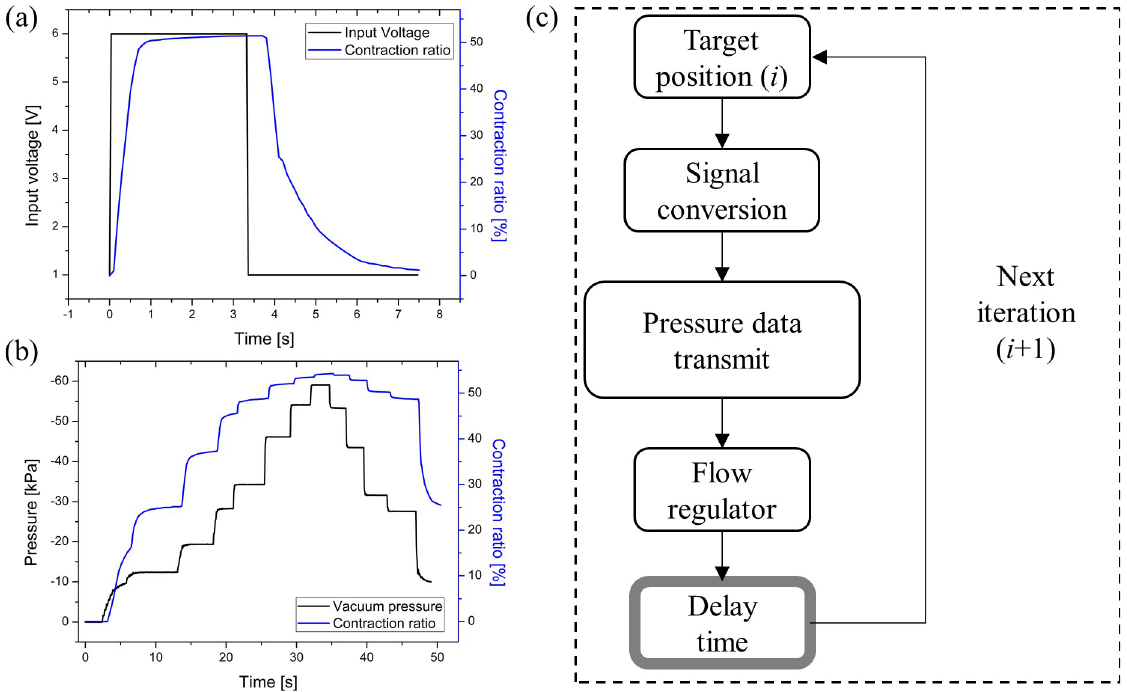
Fig 7. Dynamic characterization results: (a) step response from 0 to 6 V; (b) stepwise response with random time spans for the pressure versus the contraction ratio; (c) block diagram for open-loop control of the UH-PAM.